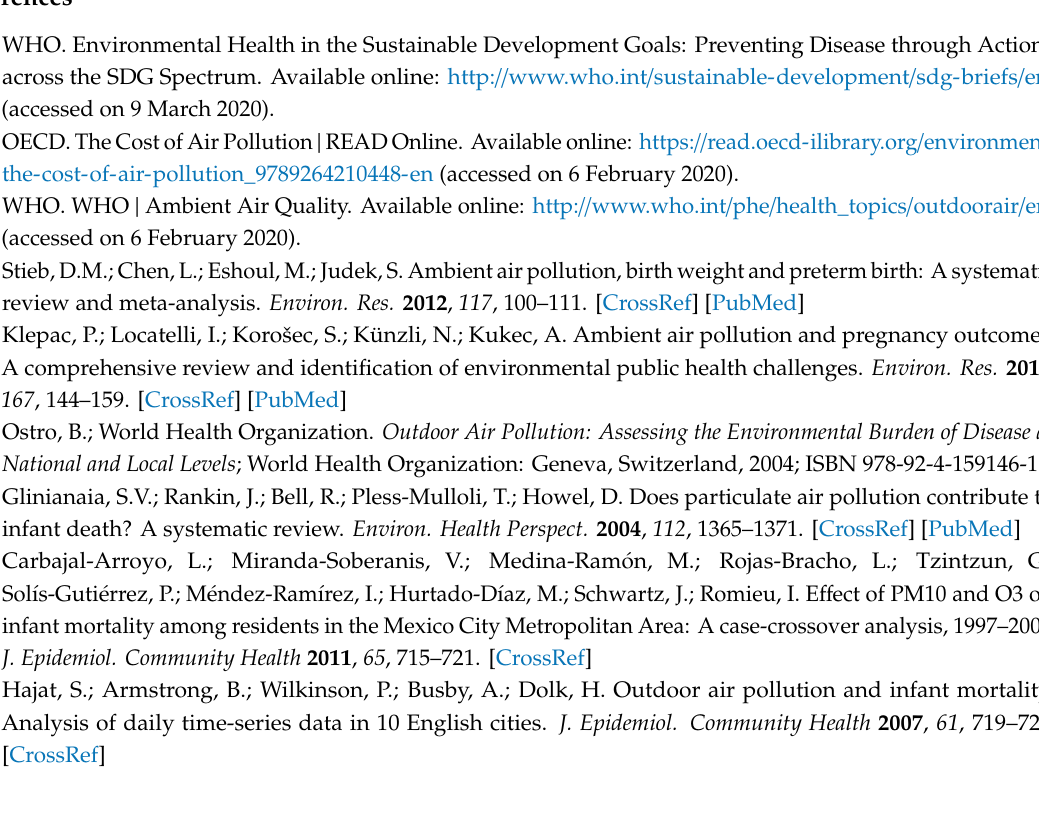
Figure S1: funel plot, Table S1: Definitions of Infant mortality outcomes and studied population (order by outcome), Table S2: Definitions of Infant mortality outcomes and measures of association for meta-analysis, Table S3: Sensitivity analysis, Table S4: Characteristics of the included studies in meta-analysis: the scores for each criterion and the quality index, S1: Text. Quality e ff ect model